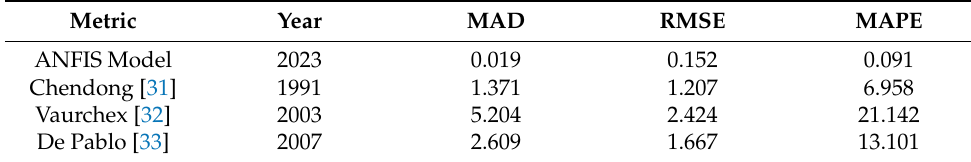
Table 1. Data Bank Statistical indicator.